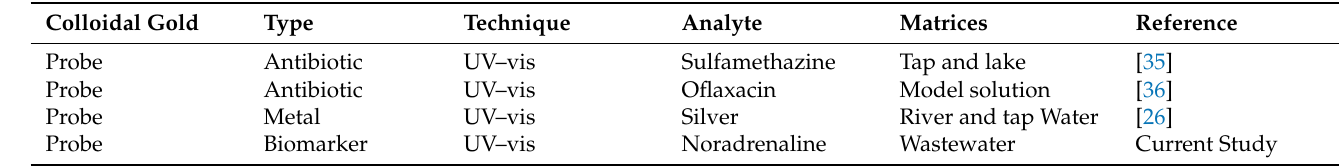
Table 3. Comparison of the current method with the